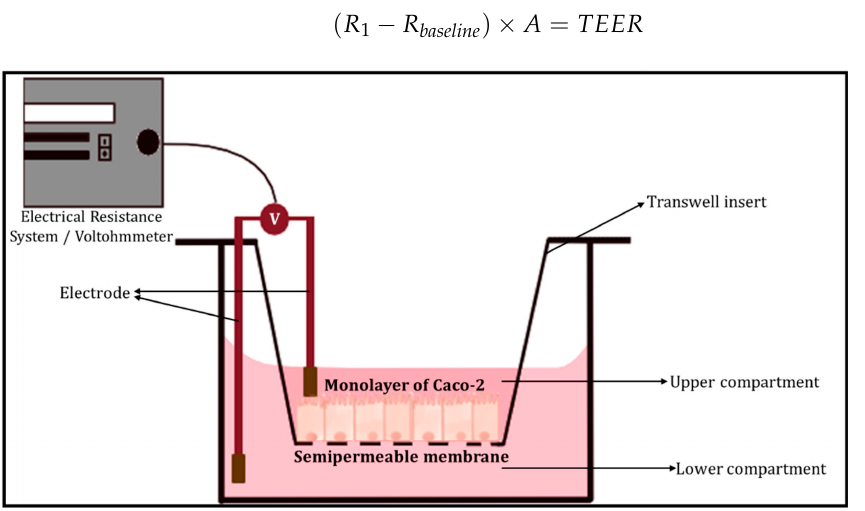
Figure 5. The classic setup used to measure TEER, using an electrical resistance sys-